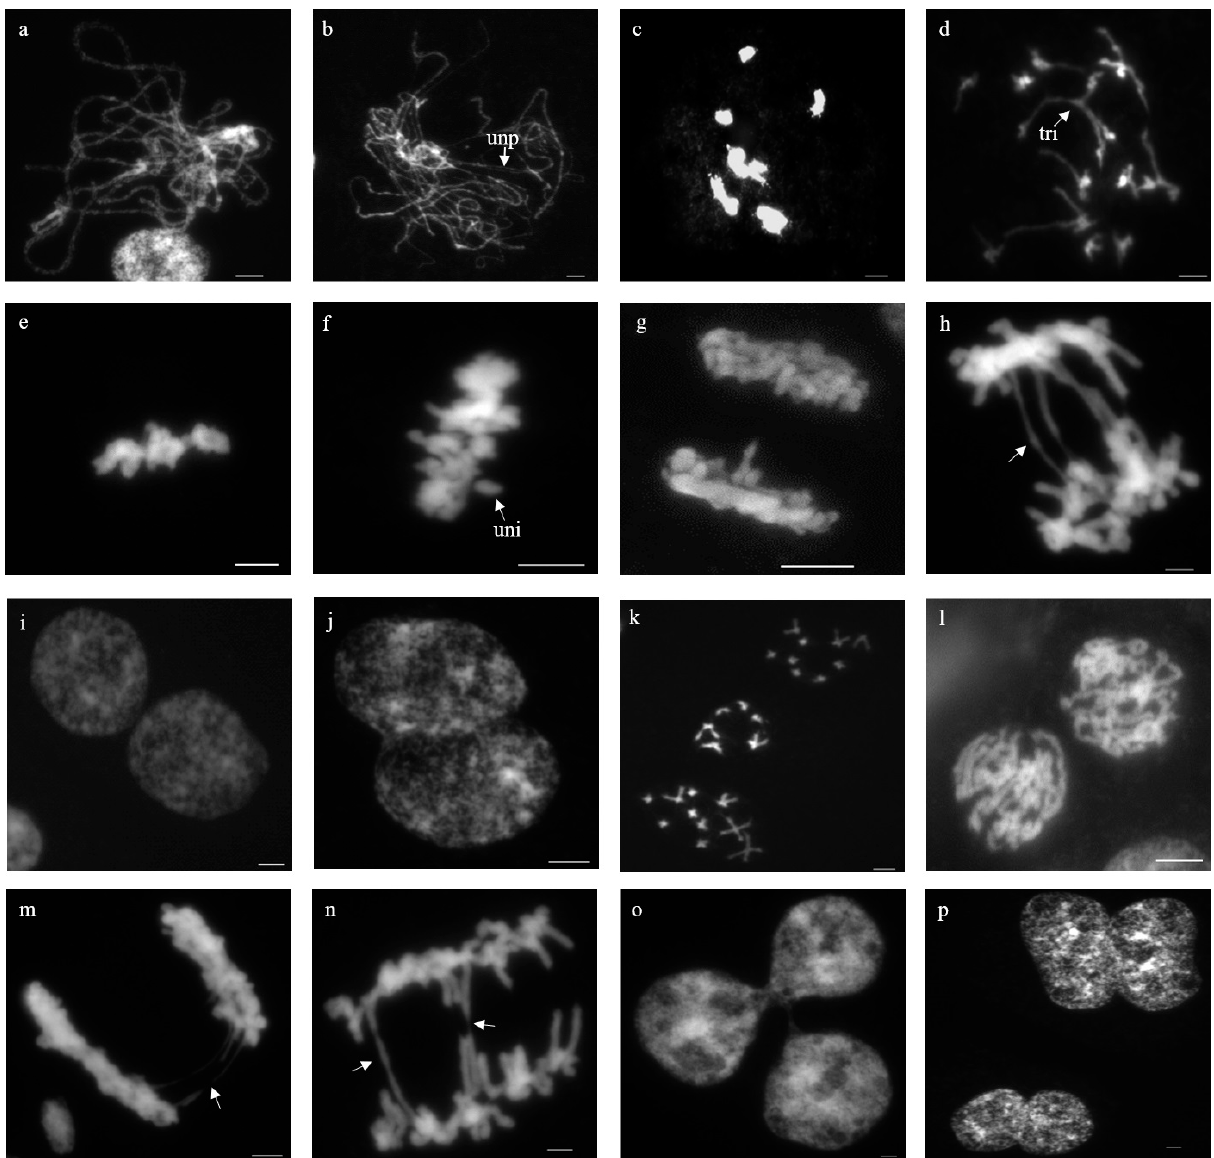
Fig. 1. Chromosome pairing and segregation in DAPI-stained male sporocytes in diploid Limonium ovalifolium and triploid Limonium algarvense . a Full pairing of chromosomes at pachytene in L. ovalifolium ; b Pachytene with unpaired (unp, arrowed) chromosomes in L. algarvense ; c Diakinesis showing eight bivalents in L. ovalifolium ; d Diplotene with trivalents (tri) and different chromosome associations in L. algarvense ; e Metaphase I in L. ovalifolium ; f L. algarvense metaphase I showing an univalent (uni, arrowed); g Anaphase I in L. ovalifo- lium ; h Abnormal anaphase I with chromosome bridges in L. algarvense (arrowed); i Dyad and fused dyads in L. algarvense ( j ); k Chromo- some arrangement after a tripolar spindle in L. algarvense showing three groups of chromosomes (10, 6 and 9, respectively totalizing 2 n = 25 chromosomes); l Prophase II in L. ovalifolium ; m Metaphase II and abnormal anaphase II ( n ) showing chromosome bridges in L. algar- vense (arrowed); o Triad fusion in L. algarvense ; p Co-existence of a fused dyad and a fused tetrad in L. algarvense . Bars = 5